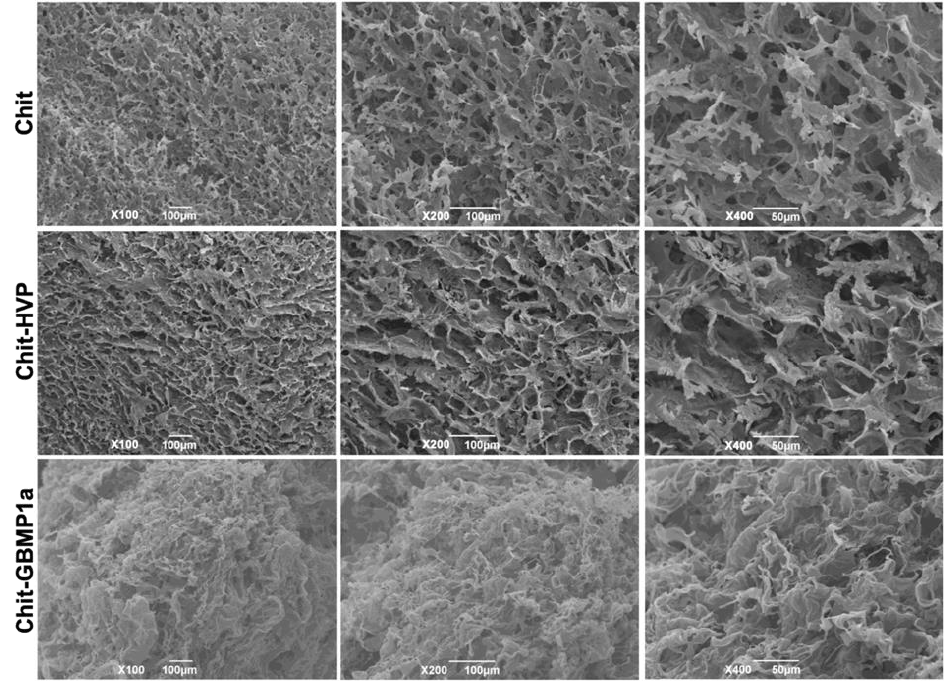
Figure 4. SEM images showing characteristic matrices morphology. Images were taken at three different enlargements, X100, X200, and X400, for Chit, Chit-HVP, and Chit-GBMP1a scaffolds. From the images of the Chit and Chit-HVP spongy matrices, it was possible to ob- serve the typical open porous structure. A slightly different morphology with softer struc- tures was observed for Chit-GBMP1a functionalized foam matrix. This could be attributed to the different nature of the two peptides: HVP peptide is highly basic and is positively charged as plain chitosan, whilst GBMP1a peptide is lightly charged (+2) and much less hydrophilic.